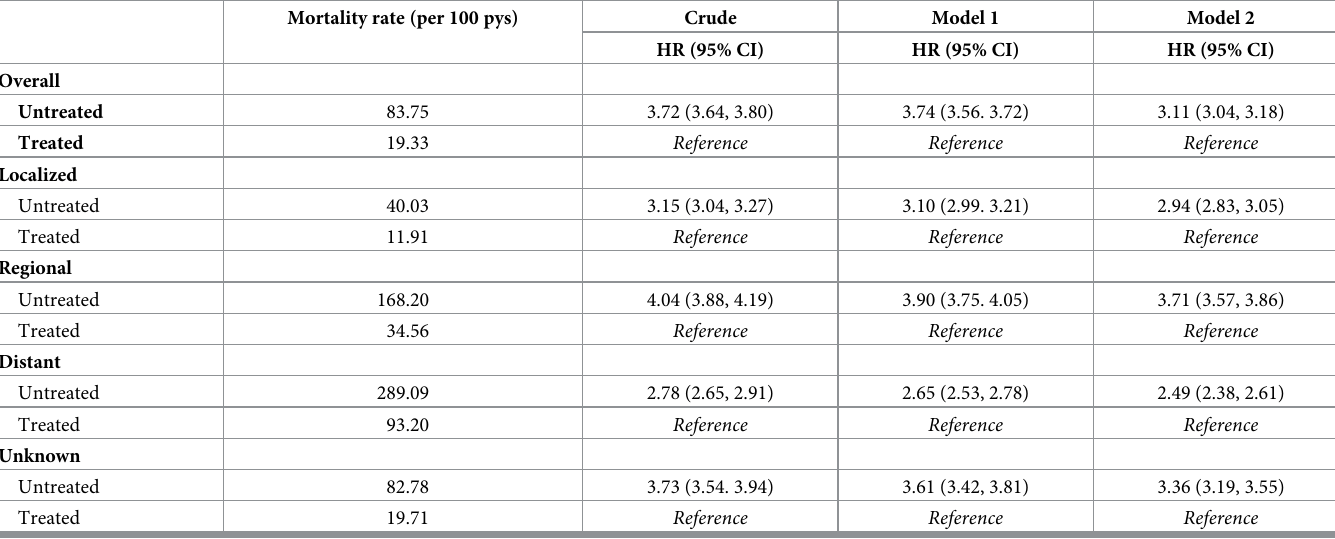
Table 3. Hazard ratios (95% confidence intervals) for all-cause mortality comparing untreated vs. treated patients with newly diagnosed hepatocellular carcinoma, overall and by SEER stage.